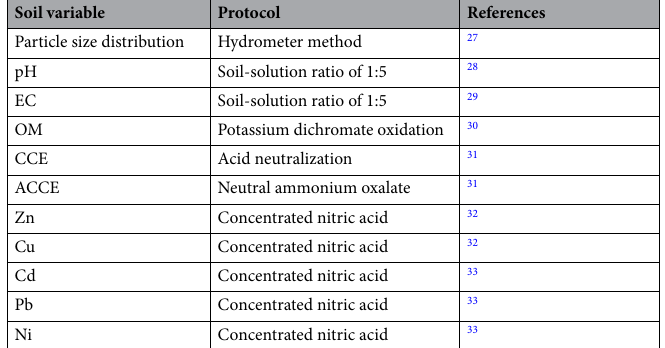
Table 1. Analytical methods used to identify soil variables. EC Electrical conductivity; OM Organic matter; CCE Calcium carbonate equivalent; ACC Active calcium carbonate.